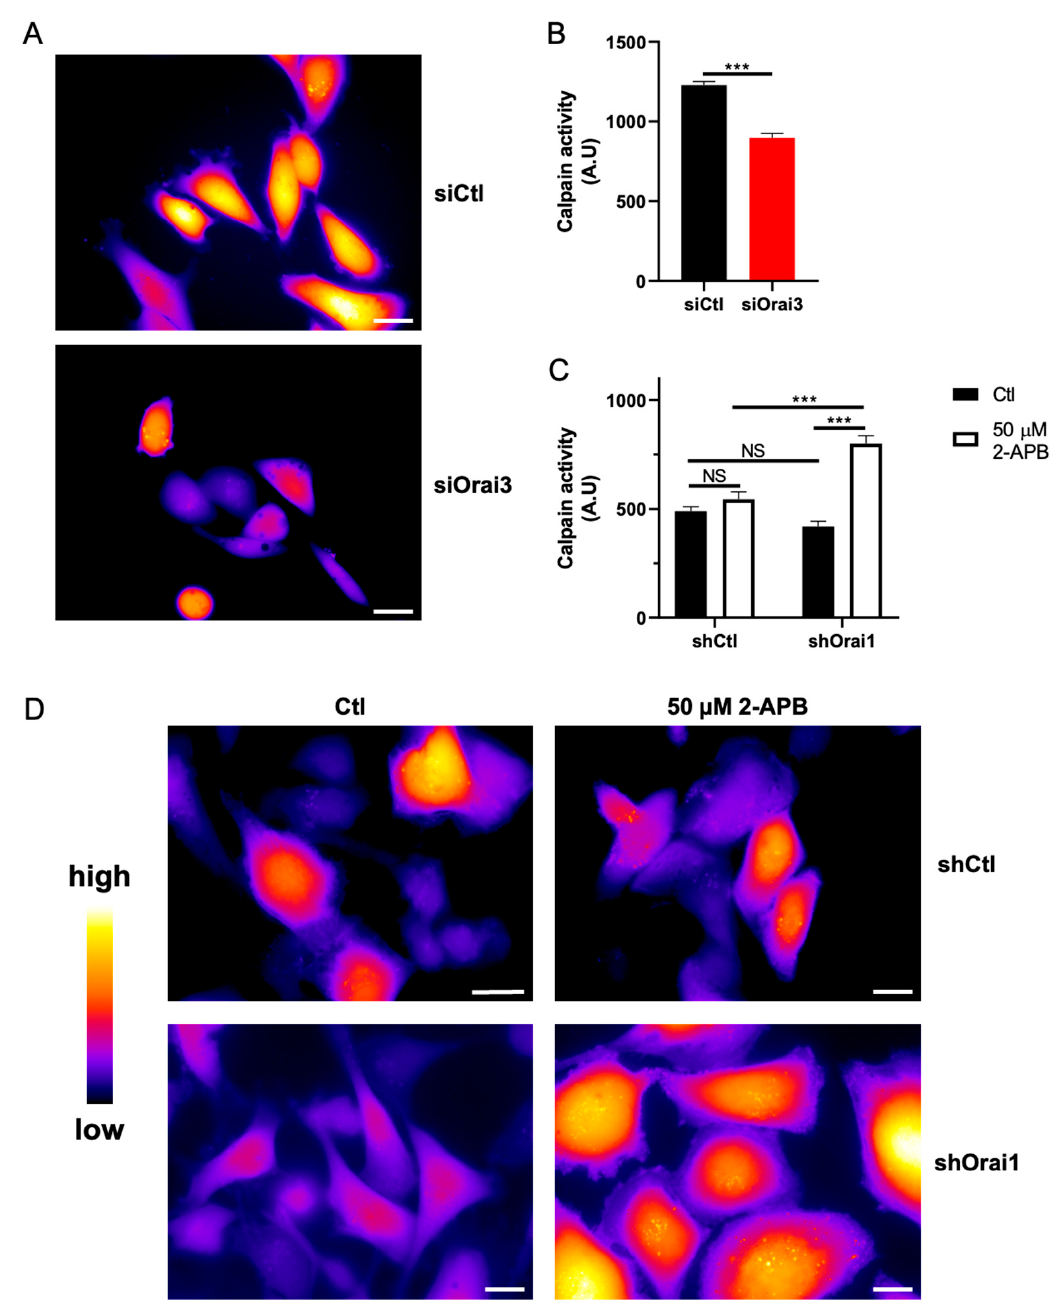
Figure 4. Orai3 silencing impairs MDA-231 cell adhesion. ( A , B ). Orai3 silencing decreased calpain activity. Representative fluorescence images ( A ) and fluorescence quantification ( B ) of calpain substrate CMAC, t-BOC-Leu-Met (siCtl n = 209; siOrai3 n = 211; N = 3; *** p < 0.001). ( C , D ). Orai3 activation with 2-APB enhanced calpain activity. Measurement ( C ) and representative fluorescence pictures ( D ) of calpain substrate CMAC, t-BOC-Leu-Met (shCtl Ctl n = 243; shCtl 2-APB n = 201; shOrai1 Ctl n = 233; shOrai1 2-APB n = 211; N = 3; *** p < 0.001; NS Non-Significant). Scale bar: 10 μ m.